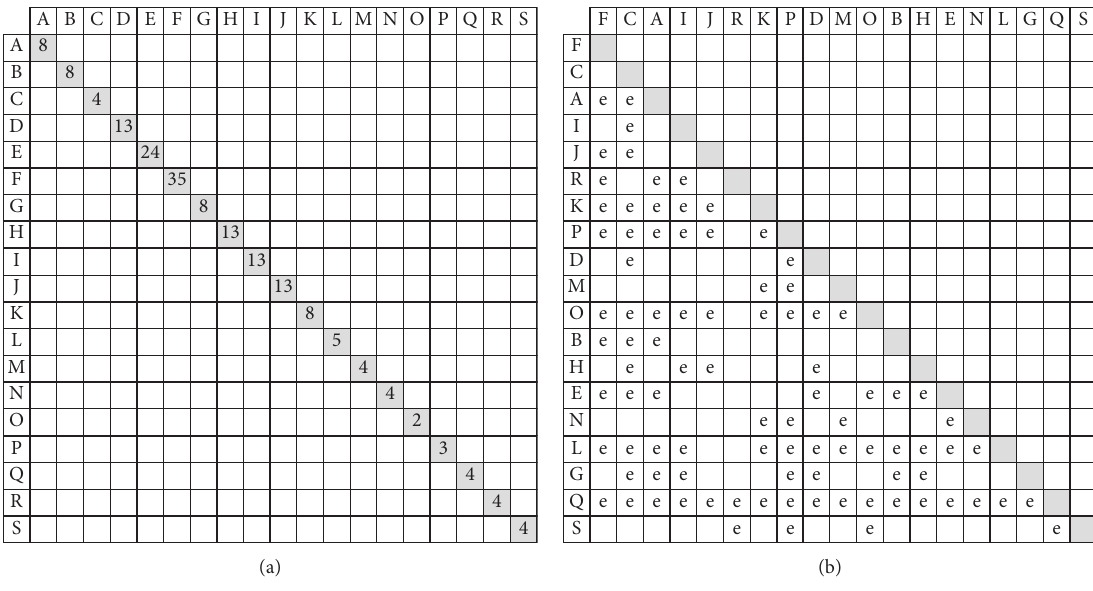
Figure 11: (a) Matrix D . (b) Matrix R (element ε is omitted).